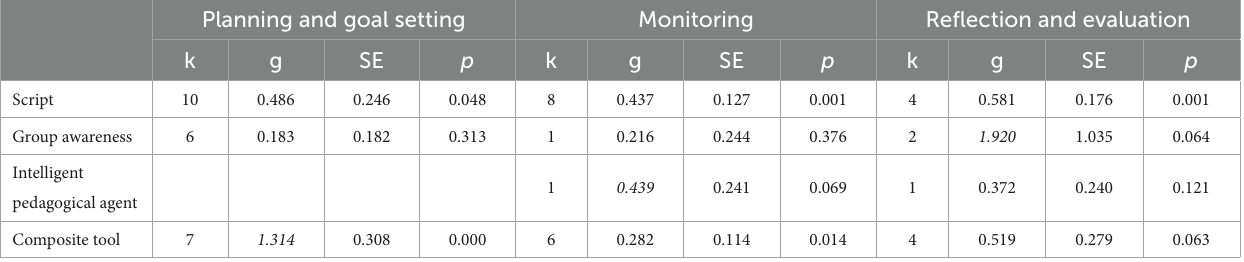
TABLE 9 Scaffolding’ effects by metacognitive